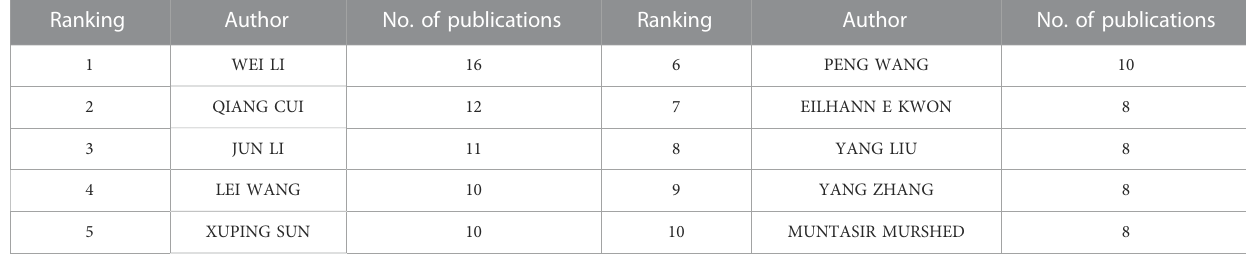
TABLE 1 Top 10 authors in terms of international publications.